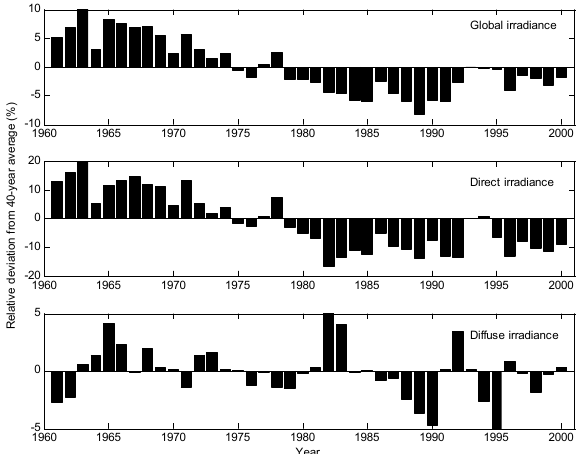
Fig. 2. Time series of all-China annual relative departures from 40- year averages in global (up), direct (middle) and diffuse (bottom) Figure 3. for 1961–2000. The series is the mean of the weighted individual departure in each station by the cosine of its latitude.